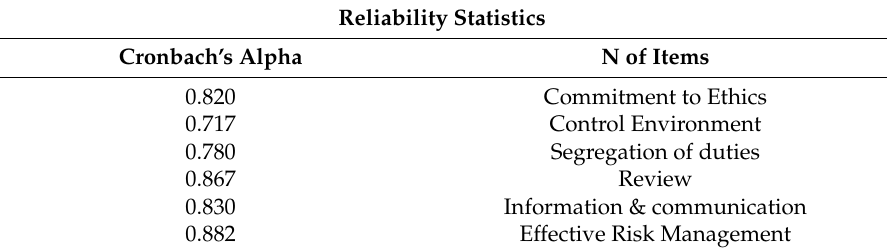
Table 1. Cronbach’s alpha of reliability threshold.